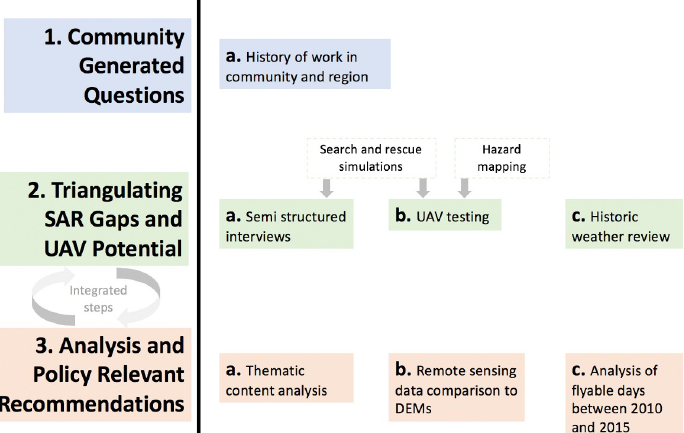
Fig 4. Study methodological process. The study draws from community-based research methods. Questions and the conceptualization of the study were generated by community interests. Data were gathered from qualitative interviews, participatory testing of UAVs, and Environment Canada historic weather observations. Drawing from grounded theory and common methods applied in the region, analysis was iteratively integrated into data collection.